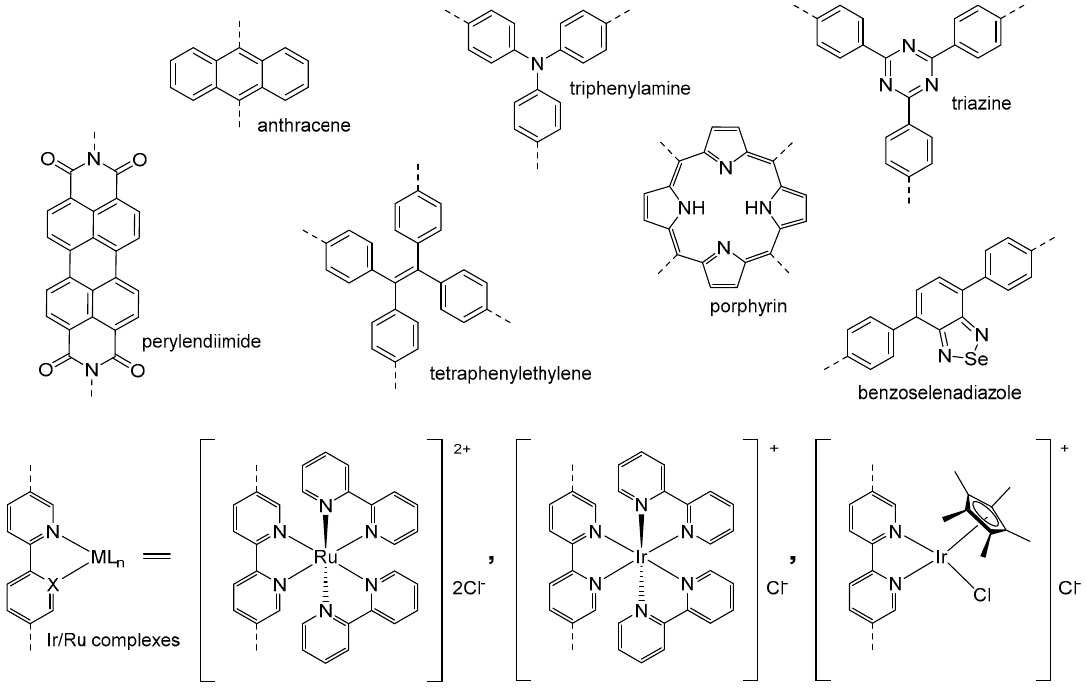
Figure 5. Photoactive incorporated linkers in pristine MOFs.